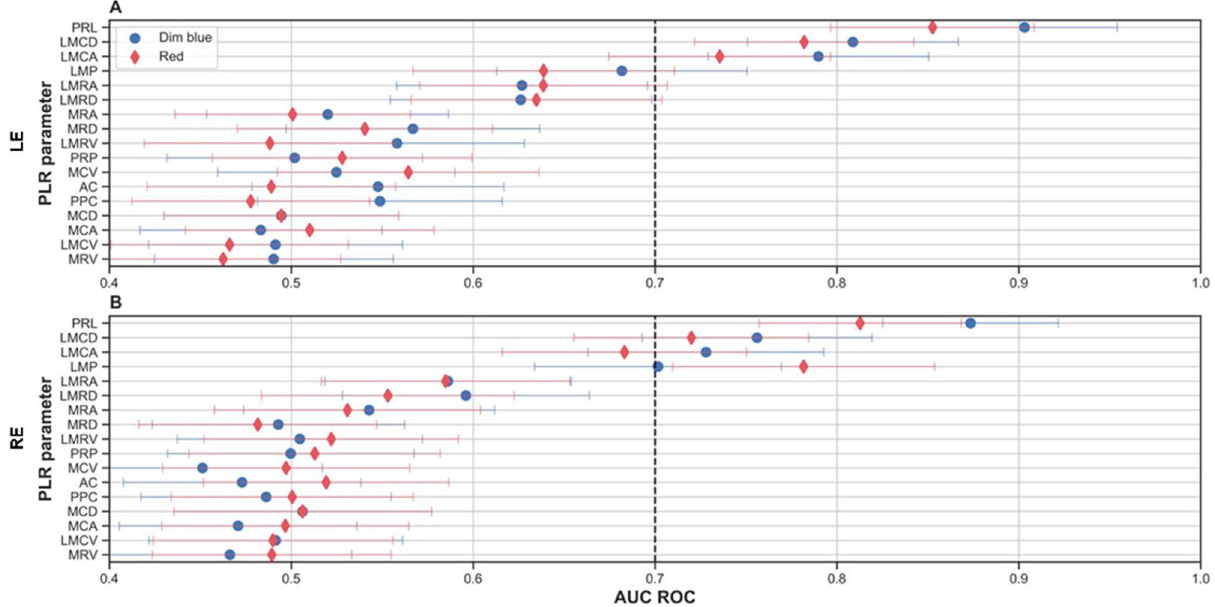
Figure 1. The mean Area Under the Receiver’s Operating Curve (AUC-ROC) for each PLR parameter for dim red (red diamond) and blue (blue circle) light stimuli in the left ( A ) and right ( B ) eyes was measured using the bootstrapping process (depicted in Fig. 6). Error bars represent the Standard Deviation (SD) for each parameter. The black dashed lines highlight the cutoff of AUC-ROC = 0.7.